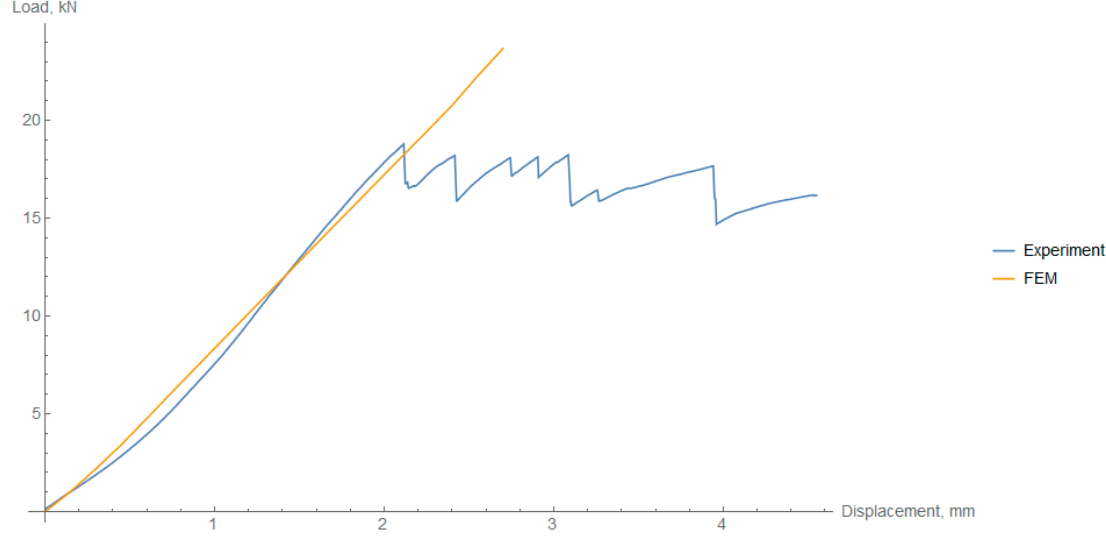
Figure 15. Comparison between experimental results of radial compression of rings and FEM analysis for the fast cooled rings.